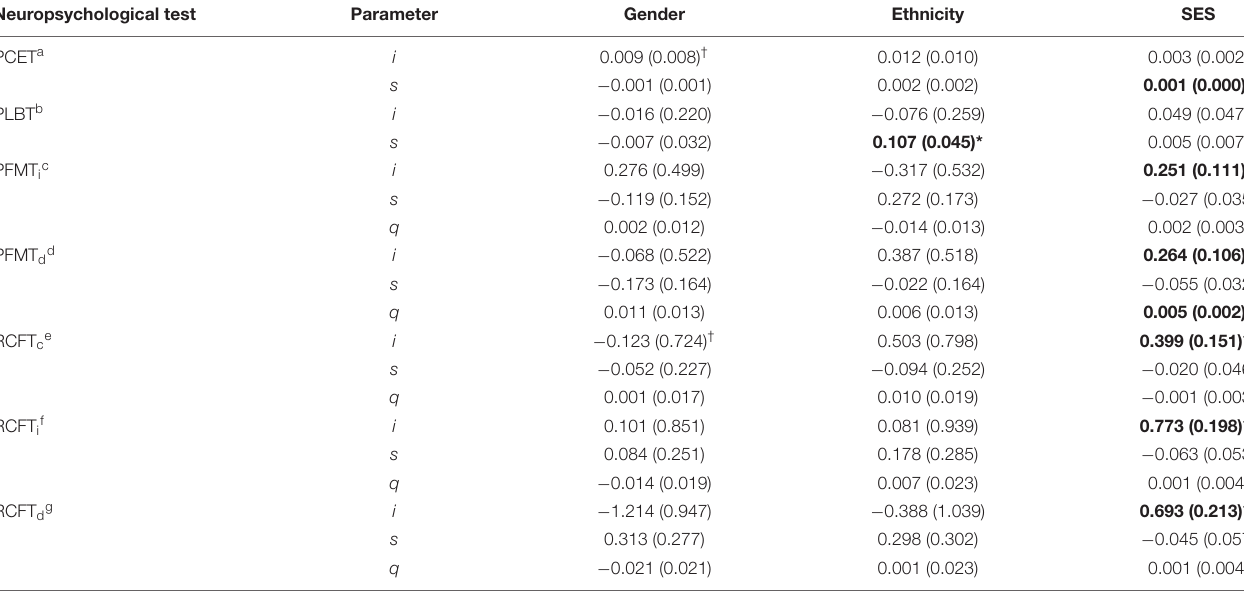
TABLE 5 | Intercept and slope factor parameter estimates for time invariant covariates (TICs). Neuropsychological